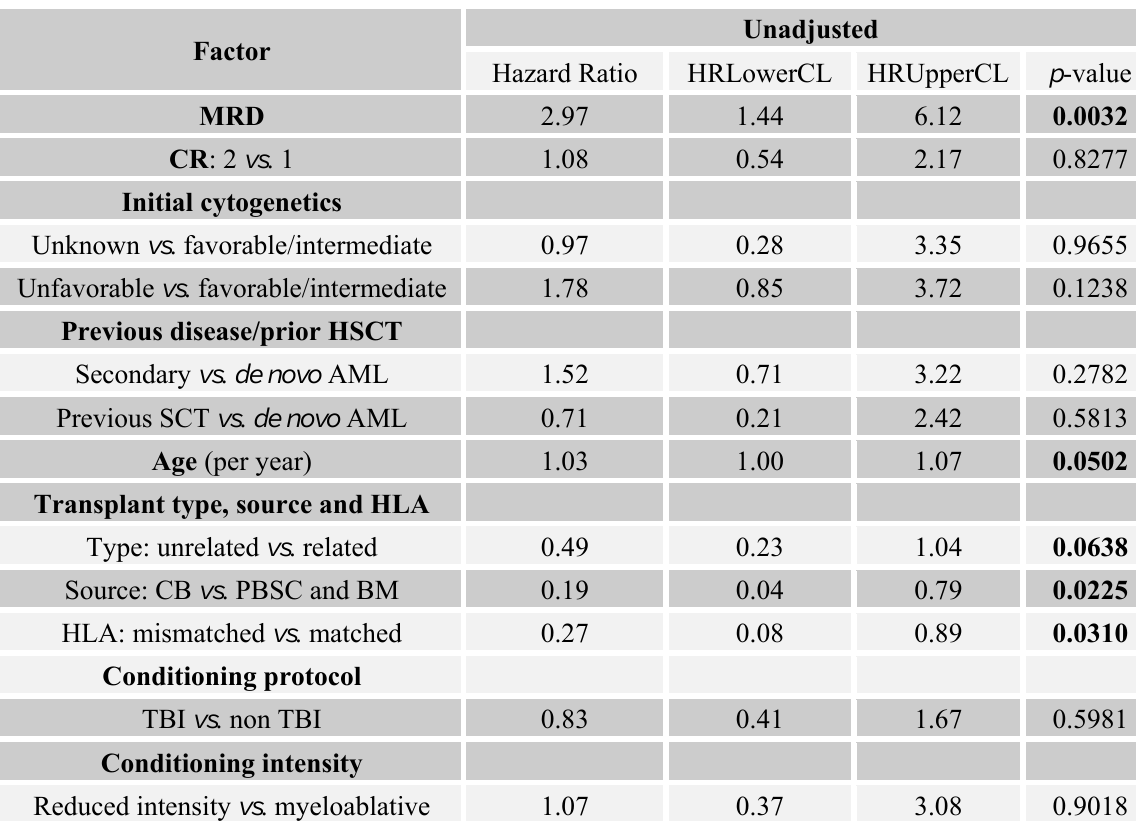
Table 4. Univariate Cox